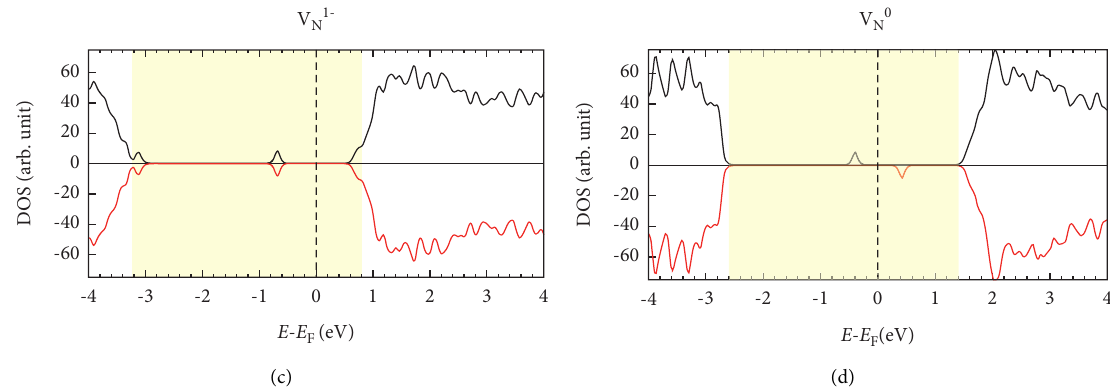
Figure 2: Density of states (DOS) of (a) neutral V areas represent the bulk band gap energy region, in which small peaks originate from localized defect states. Positive and negative DOS are for spin up and down channels, respectively.